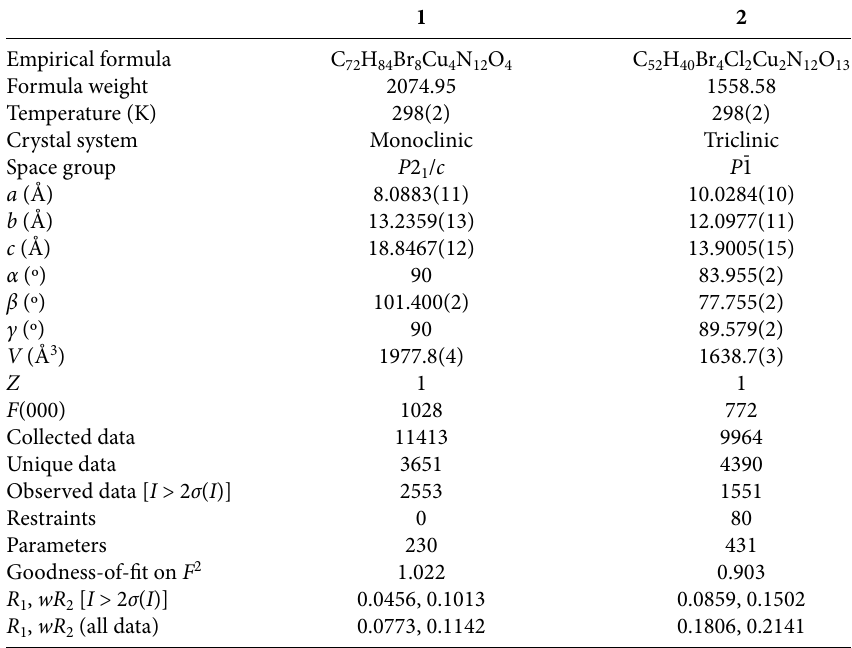
Table 1. Crystallographic data for the single crystal of the